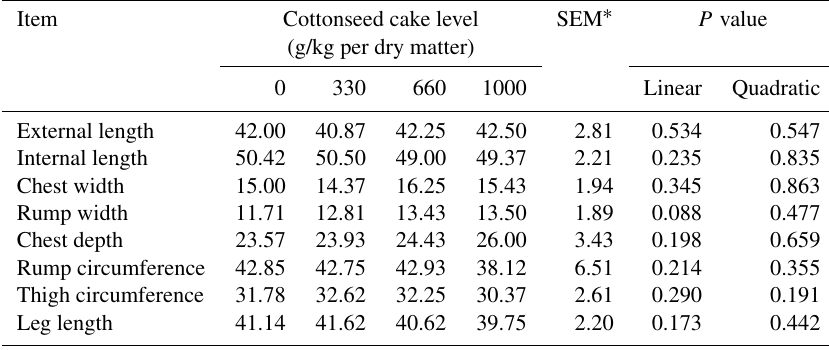
Table 4. Morphometric measurements (cm) of the carcass of feedlot goats fed diets containing cottonseed cake replacing soybean meal. Item